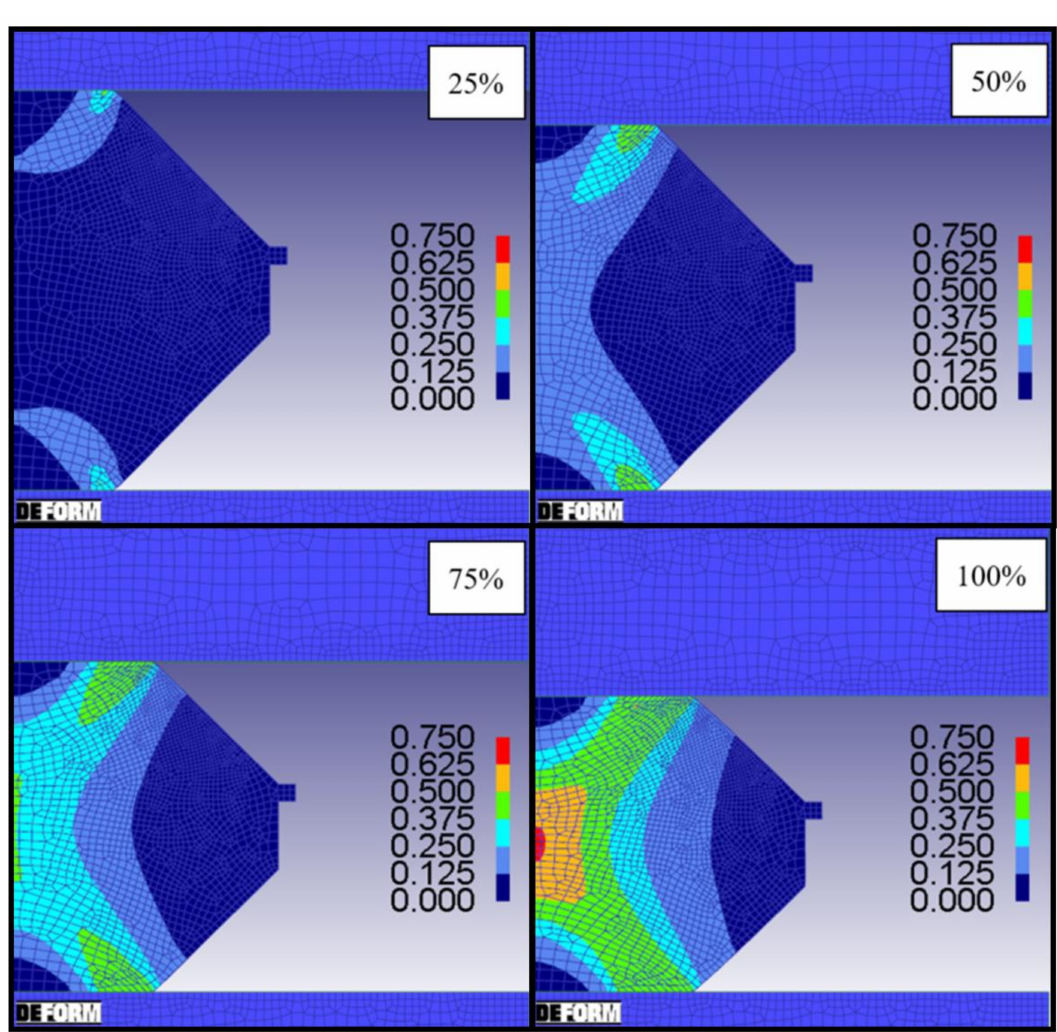
Figure 6. Simulation results at four different stages during the compression test. Local total strain during the double cone experiment: 25%—2.00 mm, 50%—4.00 mm, 75%—6.00 mm and 100%—8.00 mm top die displacement; temperature— 1020 ◦ C and strain rate—1 s − 1